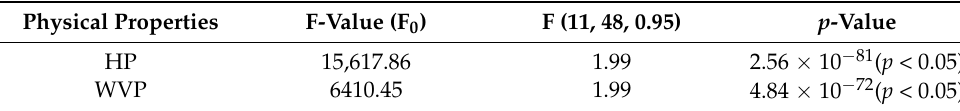
Table 3. ANOVA analysis of the fabric physical